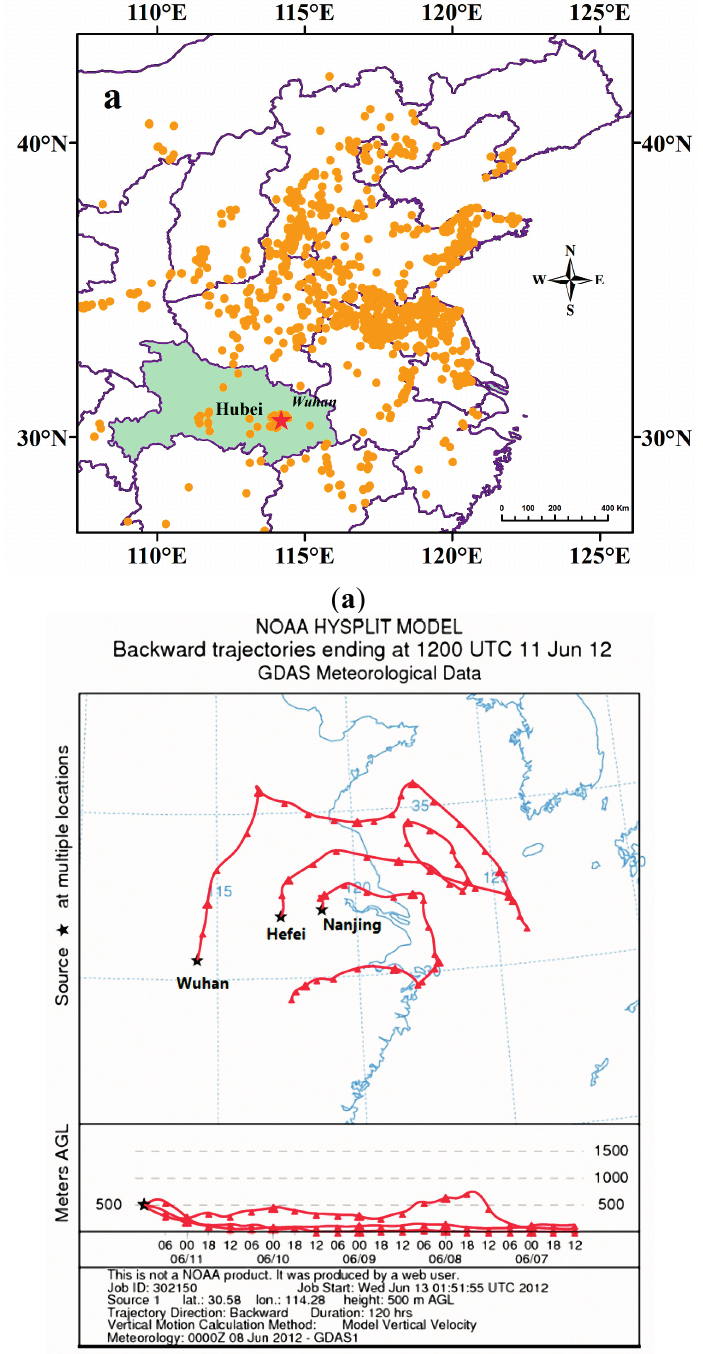
Figure 2. ( a ) Active fire data during 8–11 June 2012, in Hubei Province and surrounding provinces from MODIS global fire area products (MCD14ML) (Fire pixels are shown as orange dots); ( b ) HYSPLIT backward trajectories for haze episode in Wuhan during 7–11 June 2012 (Red denotes backward trajectories arriving at heights 500 m above ground